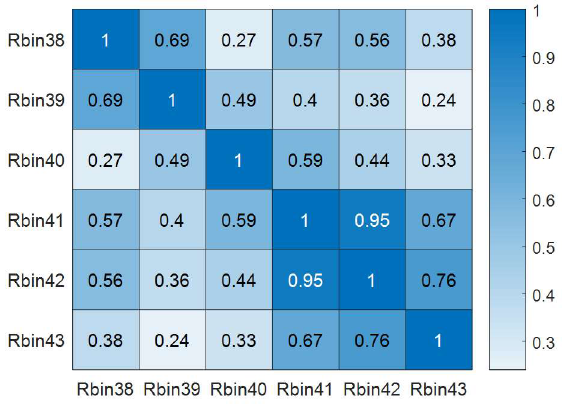
Figure 12. Linear correlation matrix between the signals of the selected Rbins. Darker blue indicates better correlation.